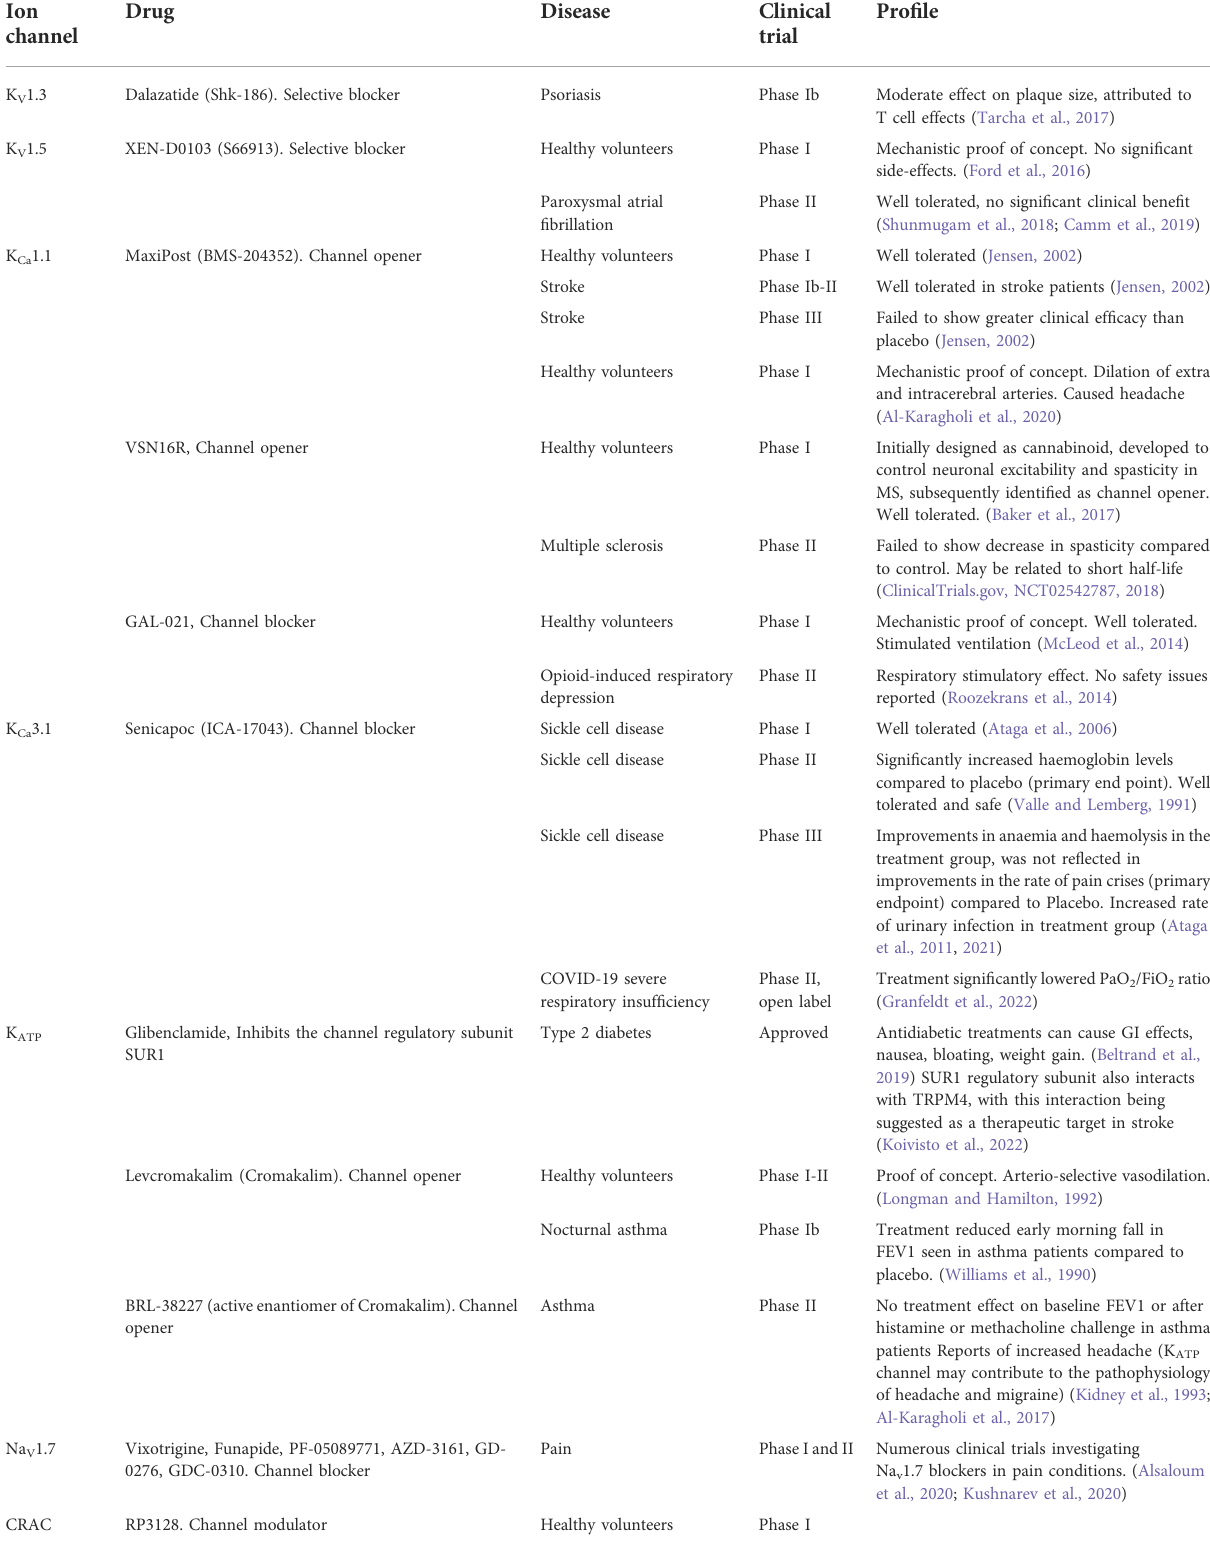
TABLE 4 Ion channel-targeted drugs in clinical trials I-III or